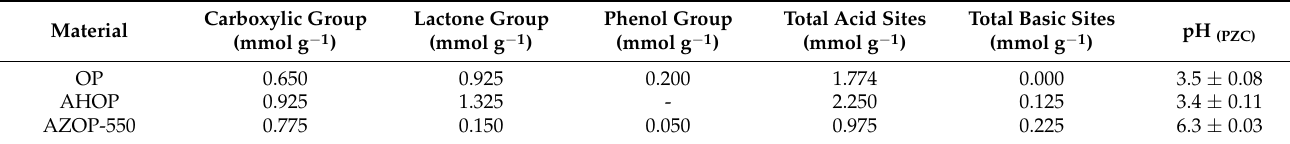
Table 2. Content of surface chemical groups for the adsorbent materials under